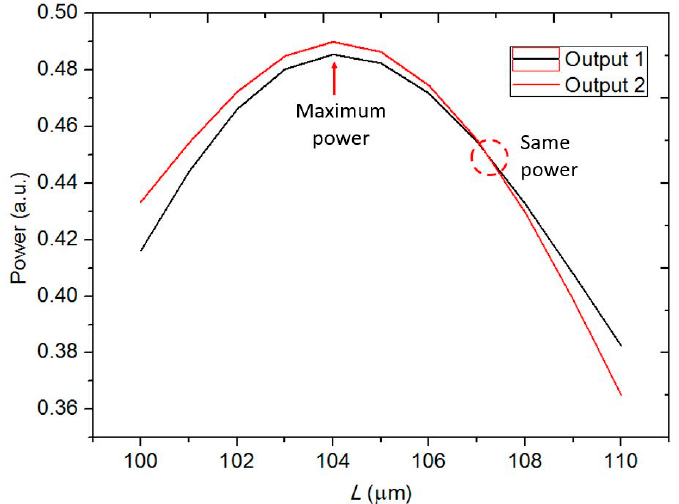
Figure 4. The dependence of two output powers on the length of the multimode waveguid e .